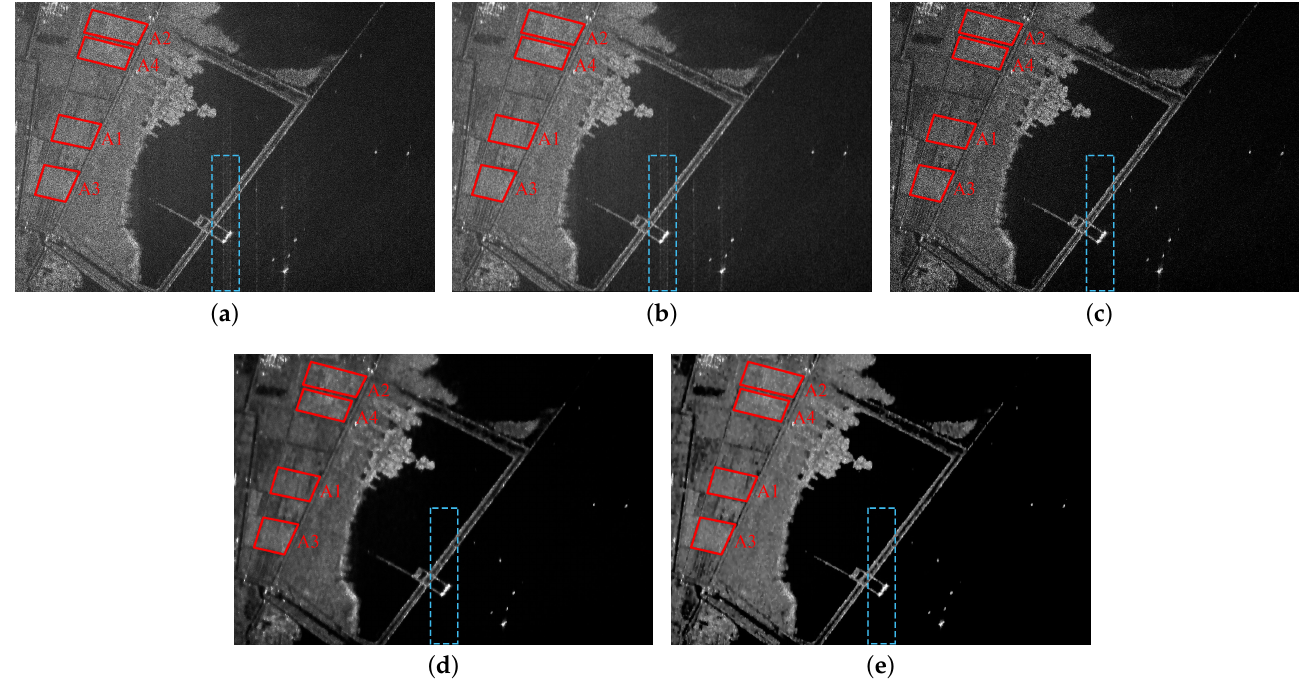
Figure 8. Experimental results for data 1 under downsampling condition. ( a ) Chirp scaling. ( b ) CSA + Multilook processing using a 5 by 5 window. ( c ) L 1 regularization. ( d ) L 1 and TV regularization. ( e ) Nonconvex and TV regularization. The vertical direction of the image is the azimuth direction, and the horizontal direction is the range direction. SAR data 1 occupies 1404 (azimuth) × 3941 (range) sampling points, and the size of the corresponding scene is 8673 m (azimuth) × 8867 m (range). All the images are plotted with the same color